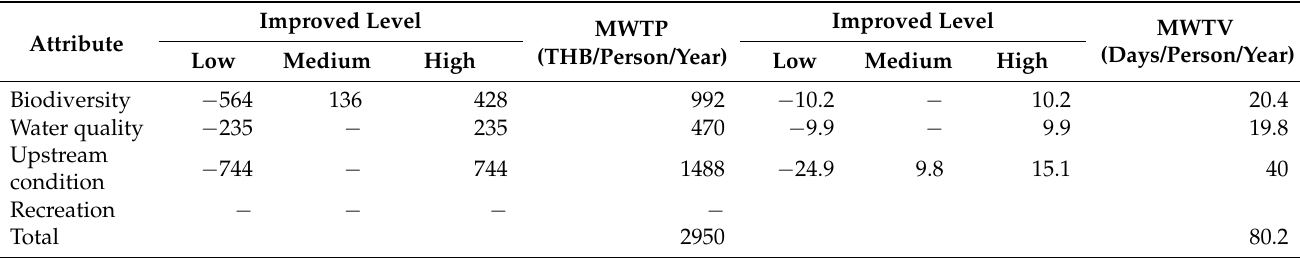
Table 8. MWTP and MWTV for each attribute improvement, and the total WTP and WTV of improved WO ecosystem services (per person per